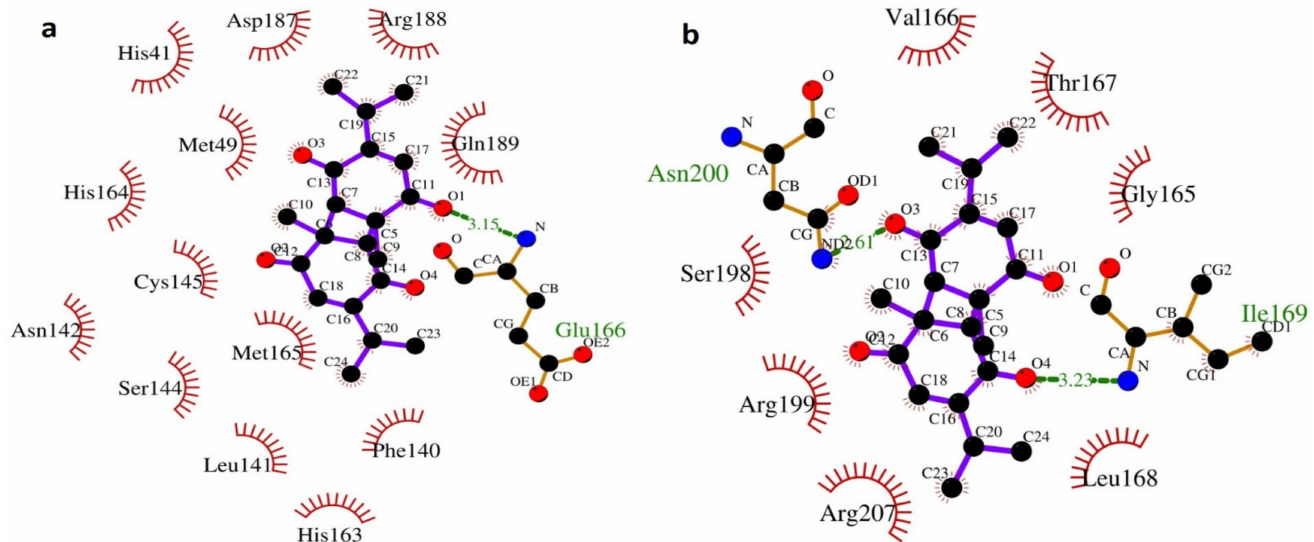
Figure 2. LigPlot 2D representation of the interaction between dithymoquinone DTQ and generating enzyme protein active sites. ( a ) DTQ with 3CLpro and ( b ) DTQ with